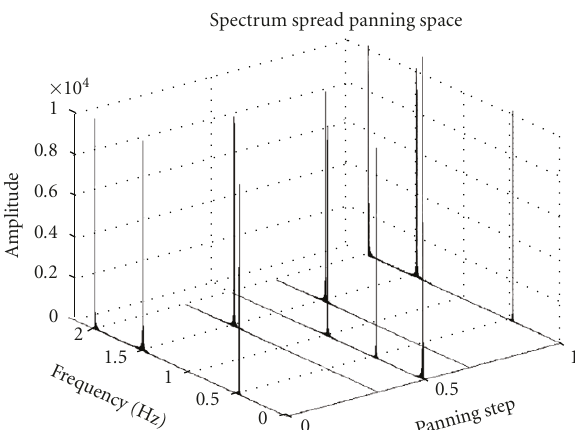
Figure 6: Results of automatic panning based on the proposed design. The test inputs were 12 sinusoids with amplitude equal to one and the following frequencies: f 1 = 125Hz, f 2 = 5kHz, f 3 = 15kHz, f 4 = 5kHz, f 5 = 20kHz, f 6 = 5kHz, f 7 = 15kHz, f 8 = 20kHz, f 9 = 15kHz, f 10 = 15kHz, f 11 = 10kHz,and f 12 = 125Hz